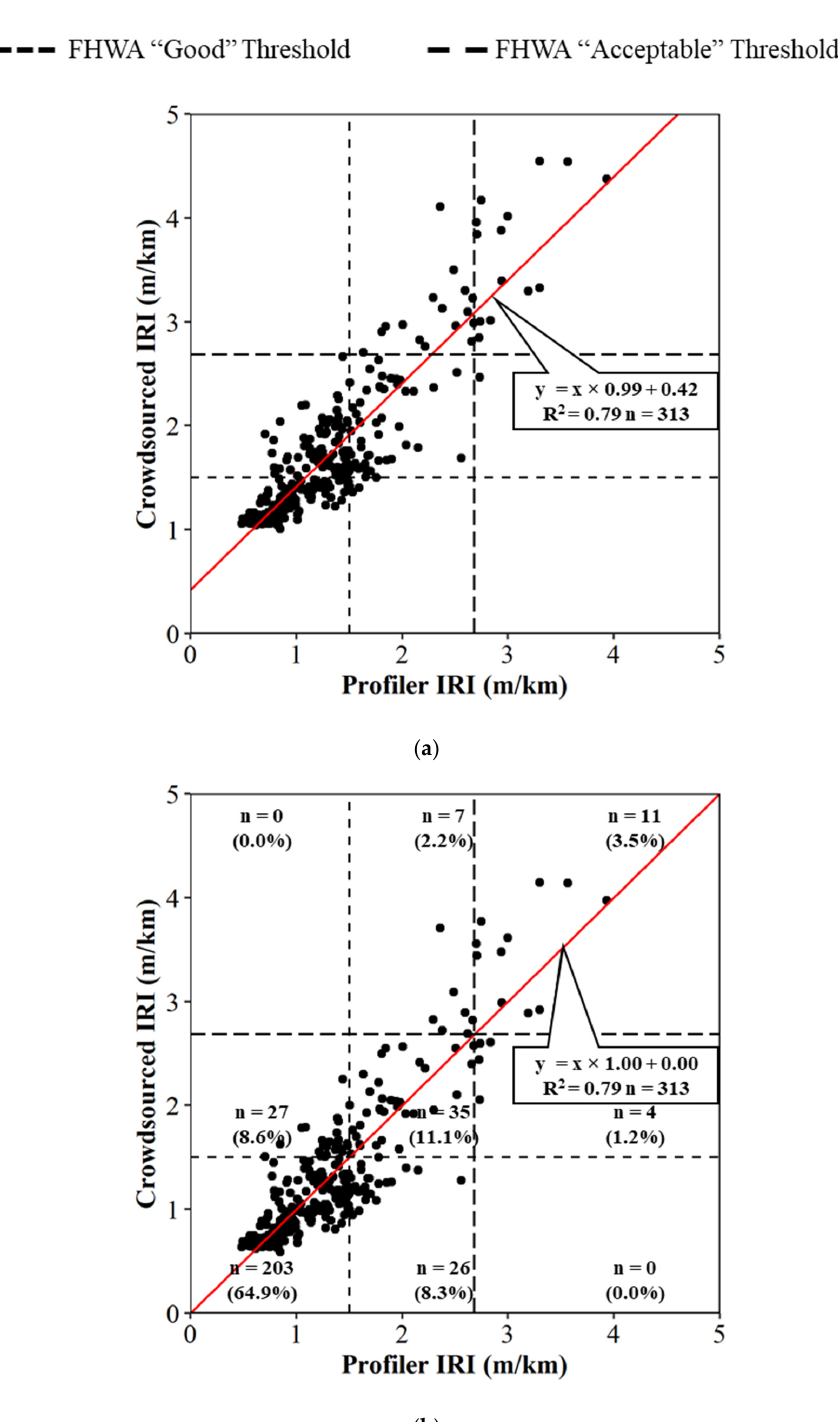
Figure 8. Linear correlation of profile IRI and crowdsourced IRI: ( a ) original data; ( b ) transformed crowdsourced data.